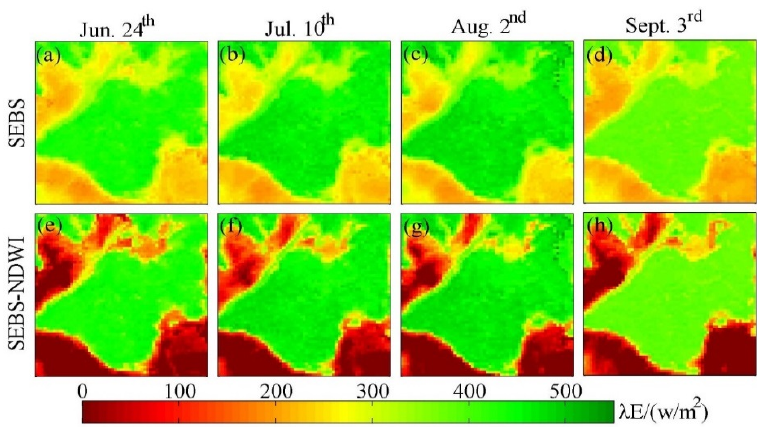
Figure 7. Instantaneous latent heat flux maps of the study area in 2012. Figure 7 show the instantaneous latent heat flux maps obtained with the original SEBS for 24 June ( a ), 10 July ( b ), 2 August ( c ), and 3 September ( d ), respectively; and the the instantaneous latent heat flux maps obtained with the NDWI-integrated SEBS for 24 June ( e ), 10 July ( f ), 2 August ( g ), and 3 September ( h ), respectively.